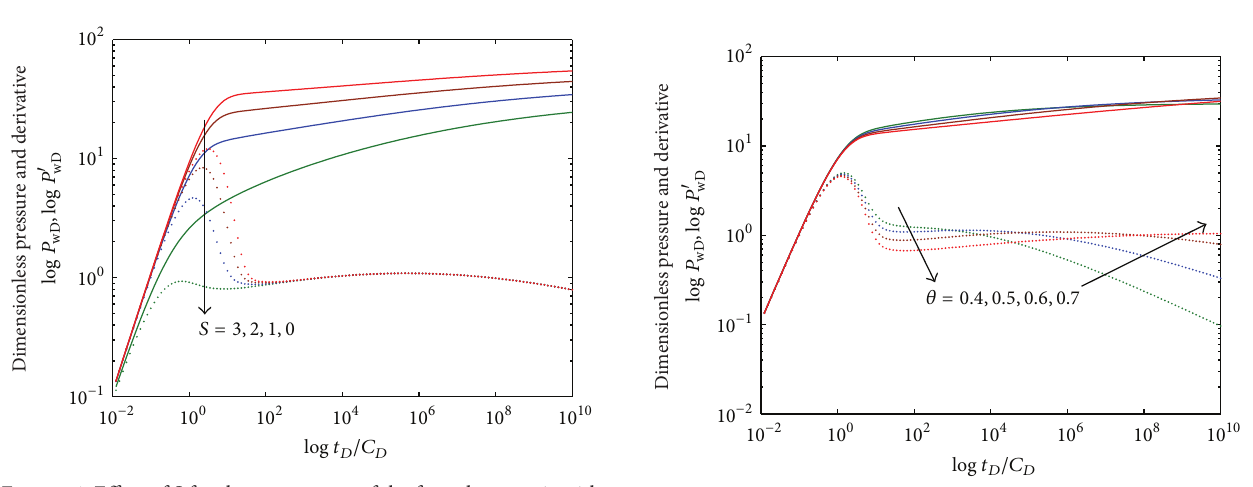
Figure 4: Effect of 𝑆 for the type curves of the fractal reservoir with spherical flow.